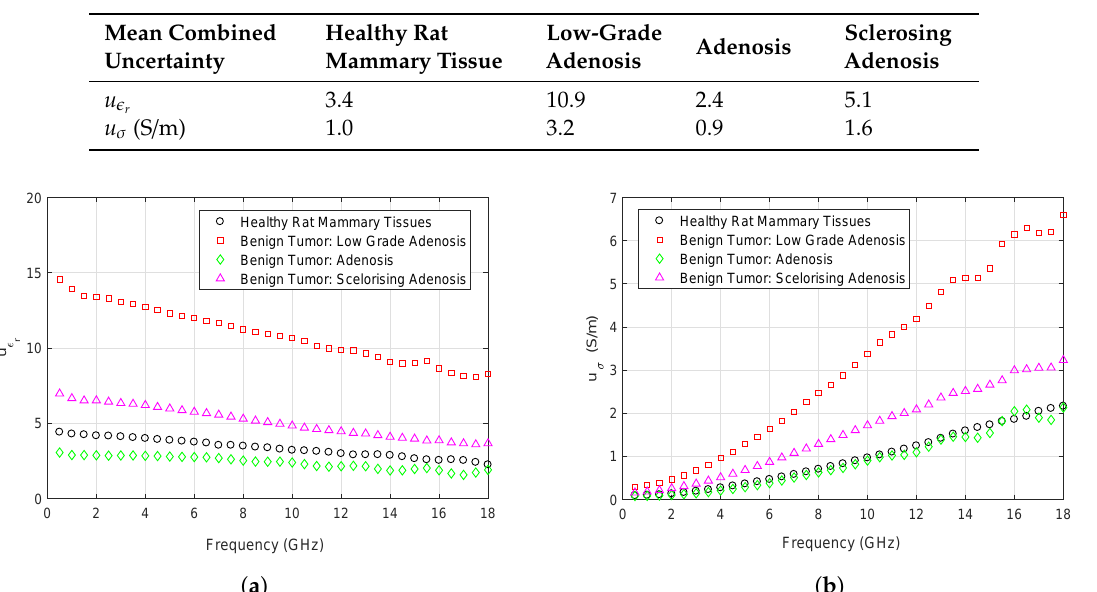
Table 3. Mean combined uncertainty for relative permittivity and conductivity of each tissue type. Mean Combined